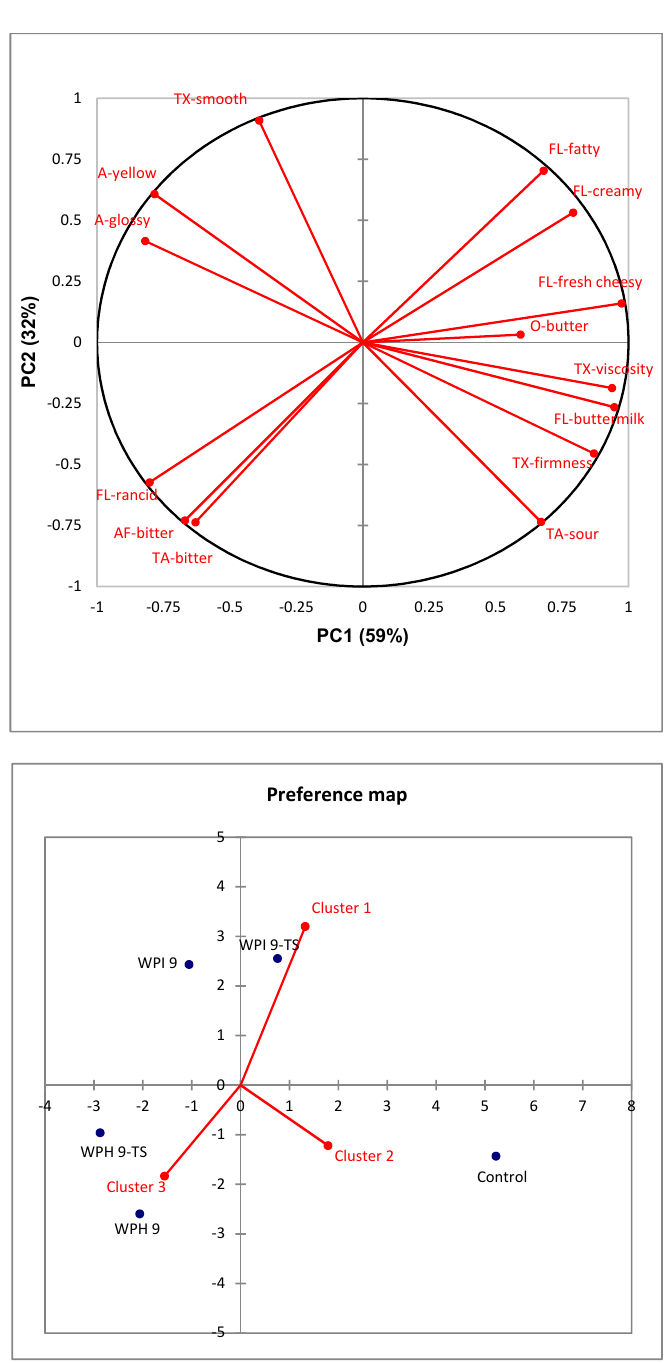
Figure 5. External preference mapping of cream cheese. Red labels: O = odor attributes; A = appearance attributes; TA = taste attributes; TX = texture attributes; FL = flavor attributes; AF = after taste attributes. Blue labels: numbers indicate amount of added protein (9 = 9%), TS = texture and taste ‐ modified samples.